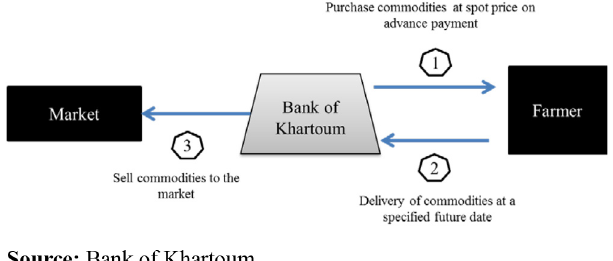
Figure 1. Mechanics of salam fi nancing offered